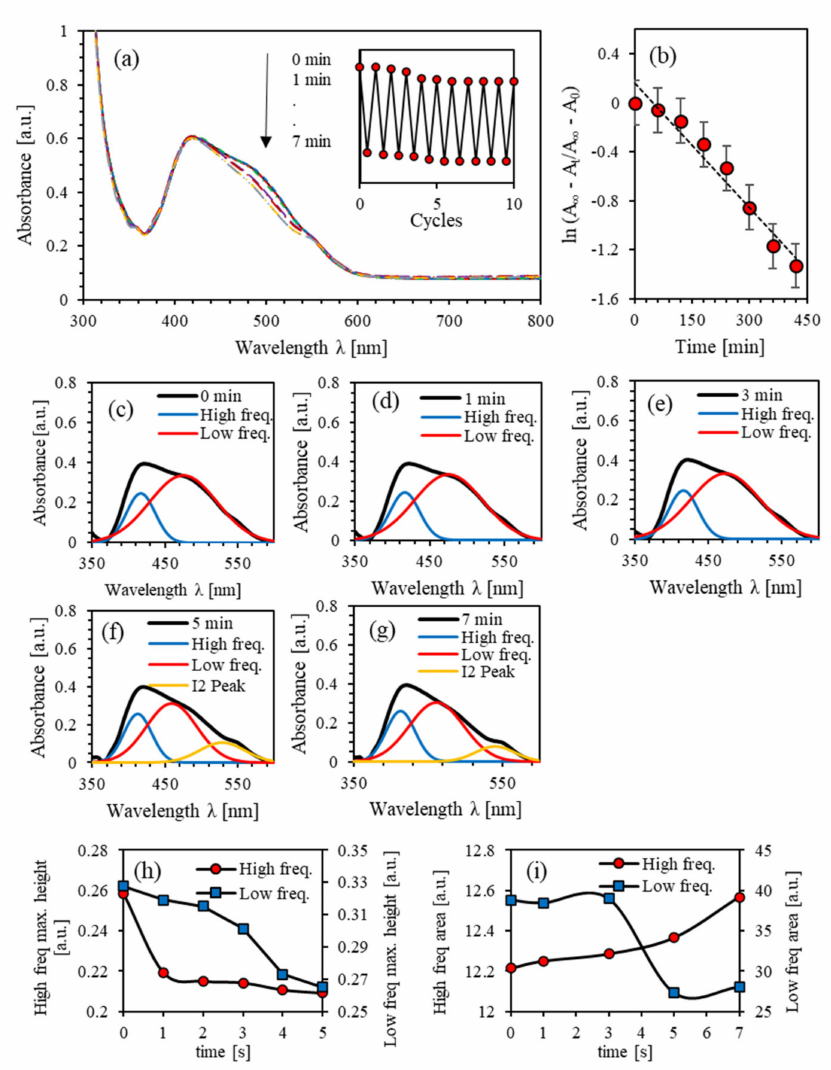
Figure 6. ( a ) Absorbance spectra of (PEO-BDK-MR)/I 2 (0.1%) complex composite thin film for various UV-illumination times, ( b ) the kinetic constants for trans → cis photoisomerization of (PEO- BDK-MR)/I 2 (0.1%) complex composite thin film, ( c – g ) Double peaks fit for the absorbance spectra of (PEO-BDK-MR)/I 2 (0.1%) complex composite thin film for various UV-illumination exposure periods, ( h ) The amplitude and ( i ) the integrated area-fit for the dual-peaks of the absorbance for the (PEO-BDK-MR)/I 2 (0.1%) complex composite thin film for various UV-light exposure